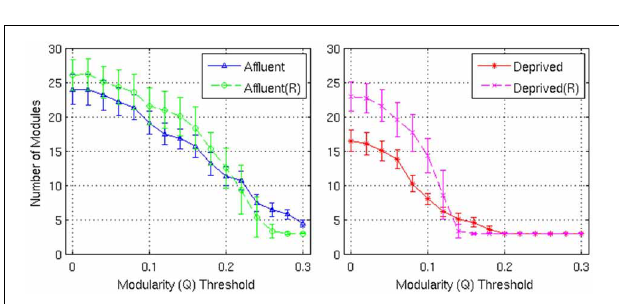
FIGURE 8 | Correlation and sparsity (Number of zeros divided by Maximum possible number of edges) relations in cortical thickness network. The most deprived have more edges (denser network) than the least deprived for a fixed correlation threshold. On the other hand the least deprived would have more false positive edges than the deprived and/or the deprived would have more false negative edges than the least deprived for a fixed sparsity. Affluent: Least deprived; Deprived: Most deprived.